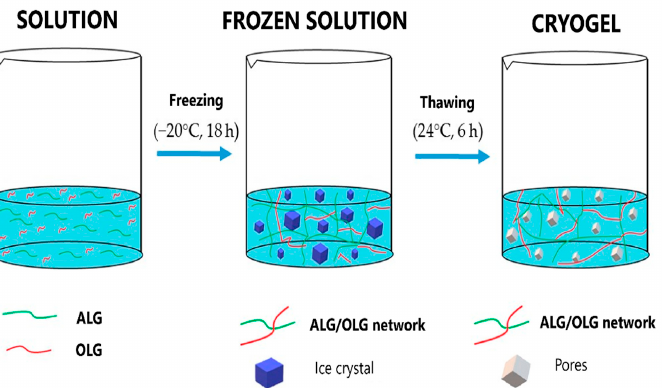
Figure 2. Schematic representation of sodium alginate cryogels preparation by the freeze-thaw method. Reprinted from [24], Marine Drugs 2019.